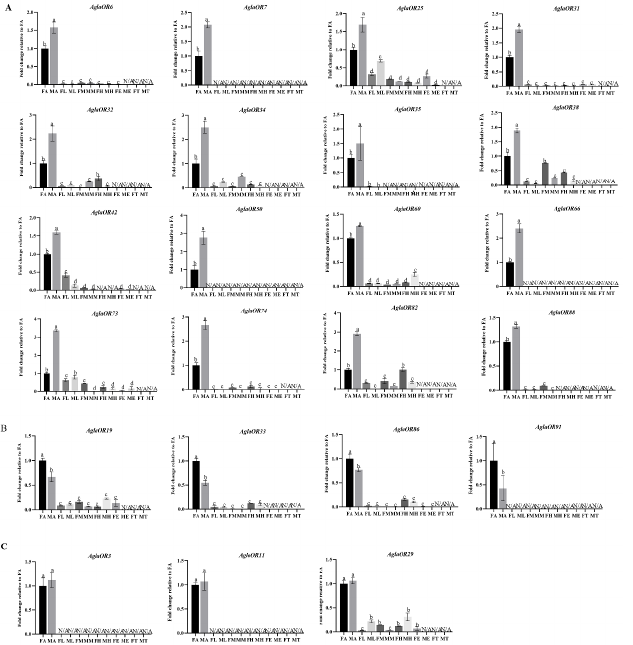
Figure 4. The expression levels of AglaOR genes in different sex tissues of adults analyzed by RT- qPCR. The gene expression of FA (female antennae) was used as the control. Actin was used as a housekeeping gene to normalize the expression level of each treatment. The relative expression lev- els represent mean ± standard error of the mean (SEM). Lowercase letters above the error bars indi- cate significant differences ( p < 0.05, LSD). N/A means that the expression level is too low to be displayed. Subfigure ( A ) represents the genes with male antenna biased expression, ( B ) represents the genes with female antenna biased expression, and ( C ) represents the genes with no significant difference between two sexes.